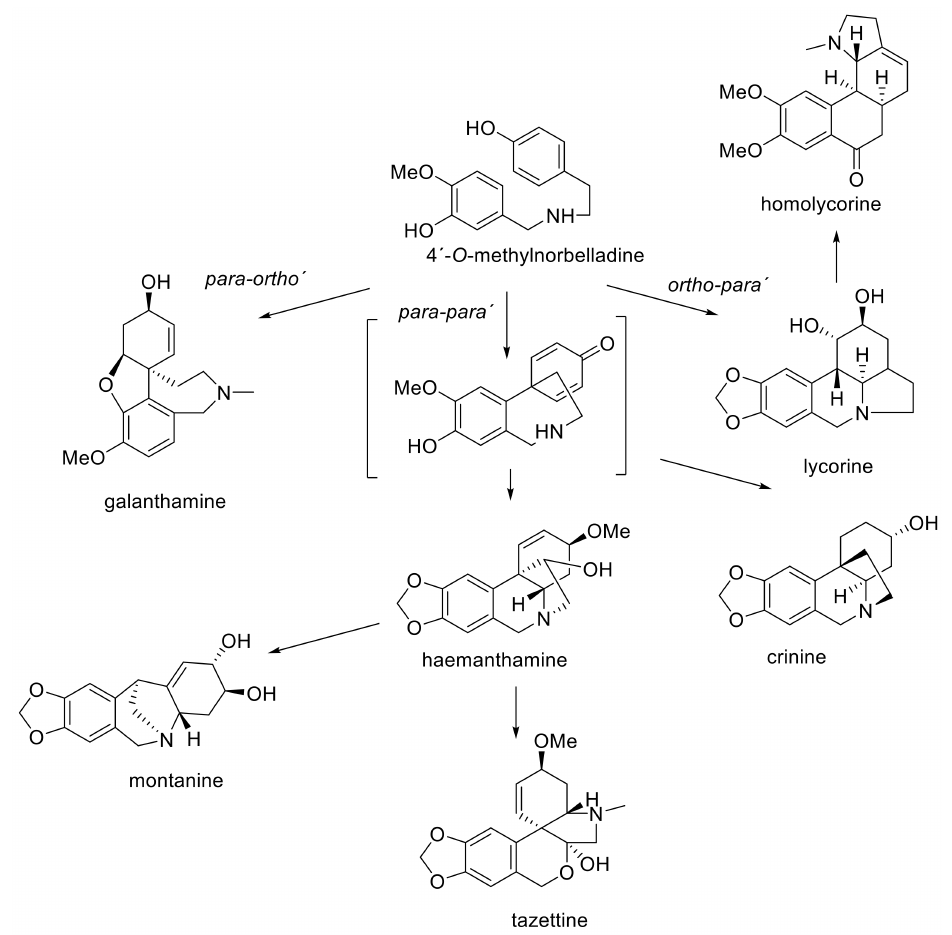
Figure 1. Biosynthetic pathway of main structural types of Amaryllidaceae alkaloids identified in the genus Nerine